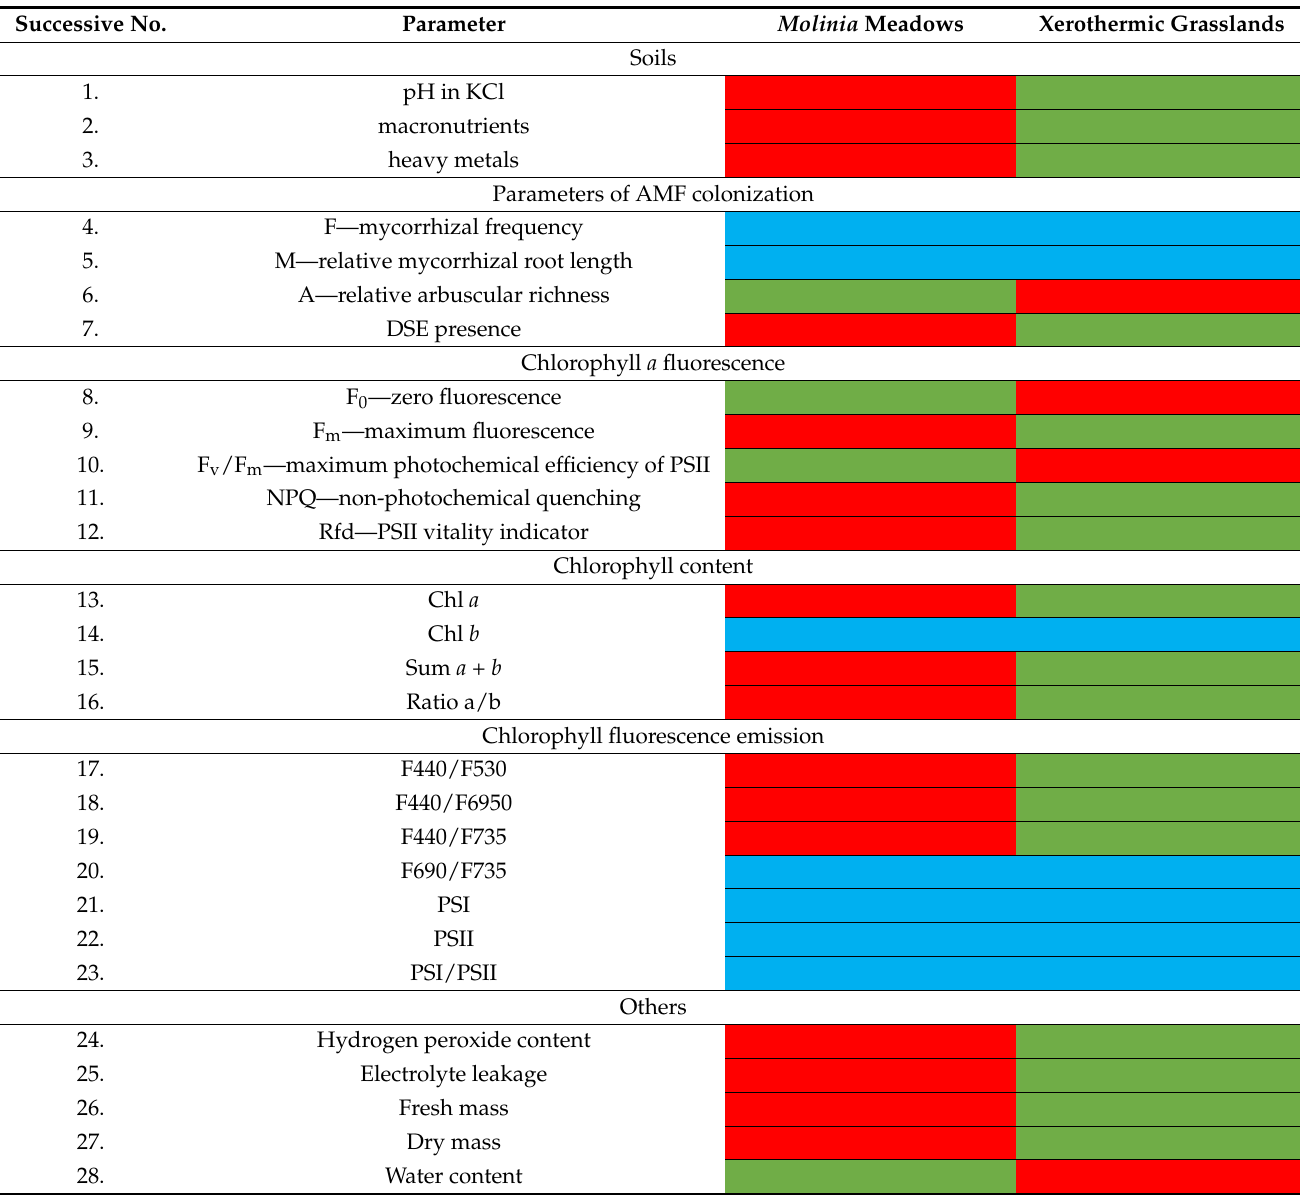
Table 3. Comparison of the studied parameters concerning the habitat and physiology of Filipendula vulgaris L.; the results of the assessment of the studied habitats and the physiological condition were differentiated by colors: favorable for the plant (green), unfavorable (red) or neutral (blue). Successive